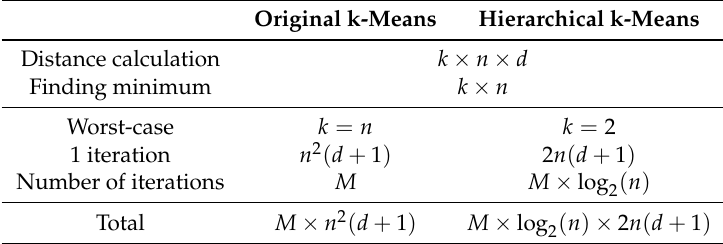
Table 2. Time complexity breakdown for k-means vs. hierarchical k-means data